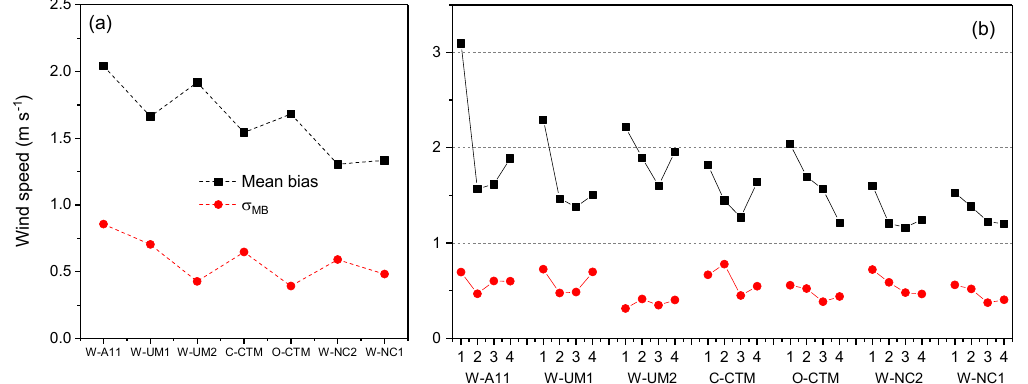
Figure 9. µ MB and σ MB of 10 m wind speed at Westmead for ( a ) the entire SPS-II campaign, and ( b ) each model and radon-based mixing state (categories #1 to #4, Table 1).